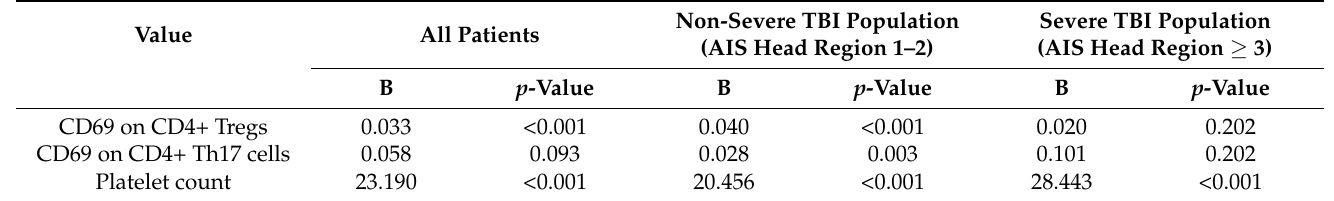
Table 2. Overview of the subgroup analysis for patients with traumatic brain injury. AIS, Abbreviated Injury Severity